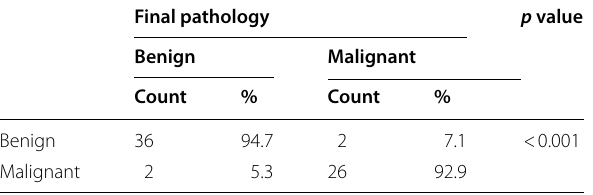
Table 4 CE-MRI categorization of lesions based on their morphology in correlation to the final histopathology results